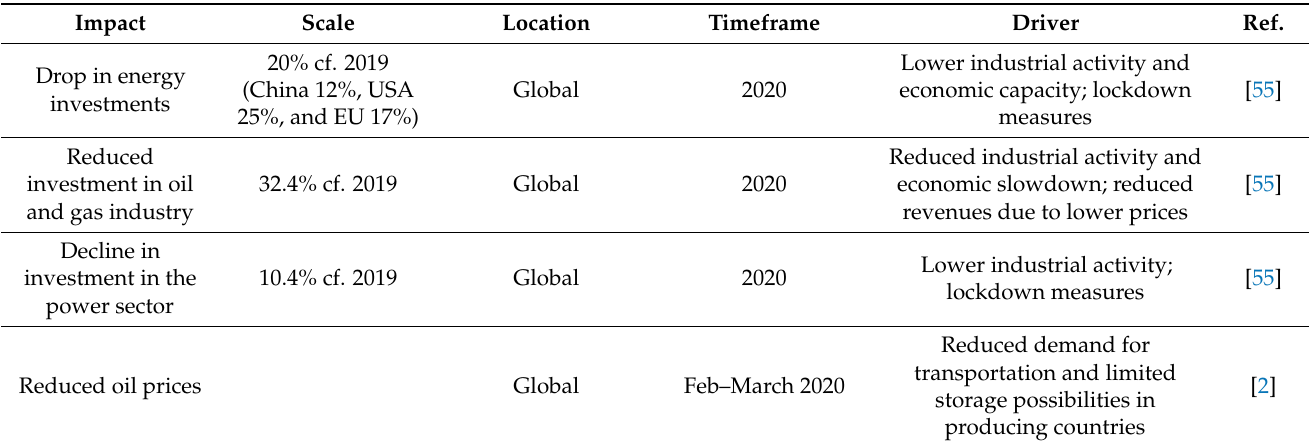
Table 1. Impacts of COVID-19 on the upstream supply of energy commodities and